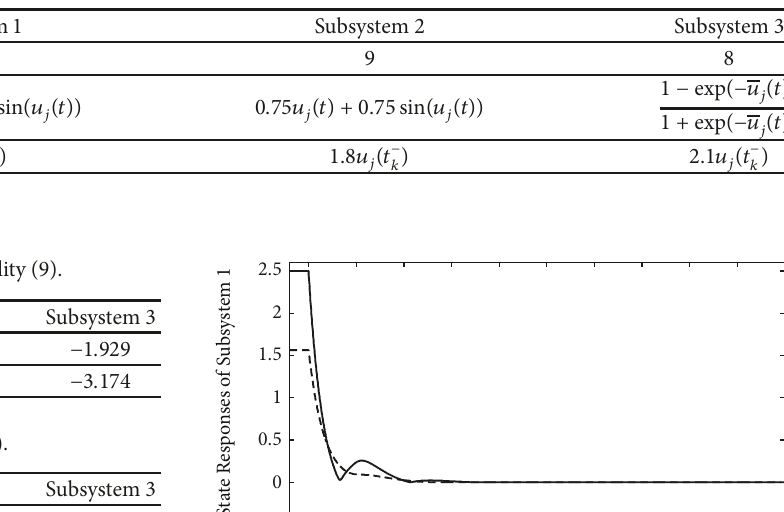
Table 1: Assumptions for (2) with 𝑗 = 1,2 .